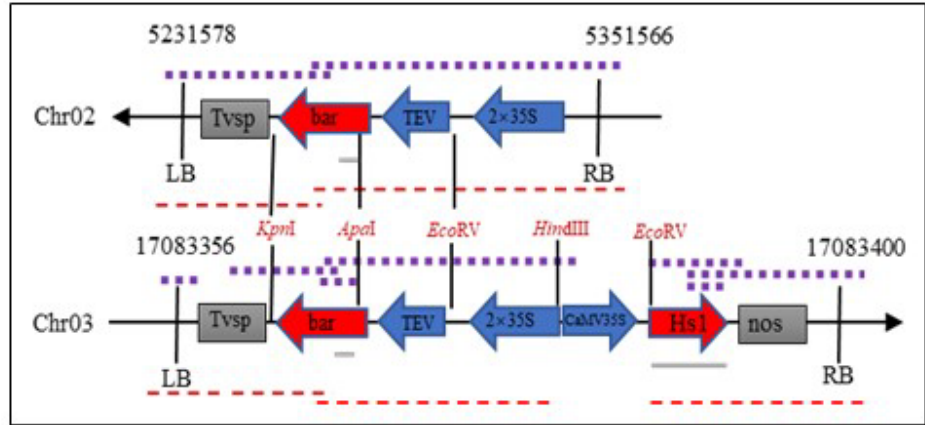
Figure 5. Schematic diagram of a T-DNA insertion sites of the ZHs1-2 transformation event. LB, left border; RB, right border. The purple dotted line represents the location of the PCR amplified product; the red dotted line represents sequencing fragments, and the grey solid line represents the Southern hybridization probe.